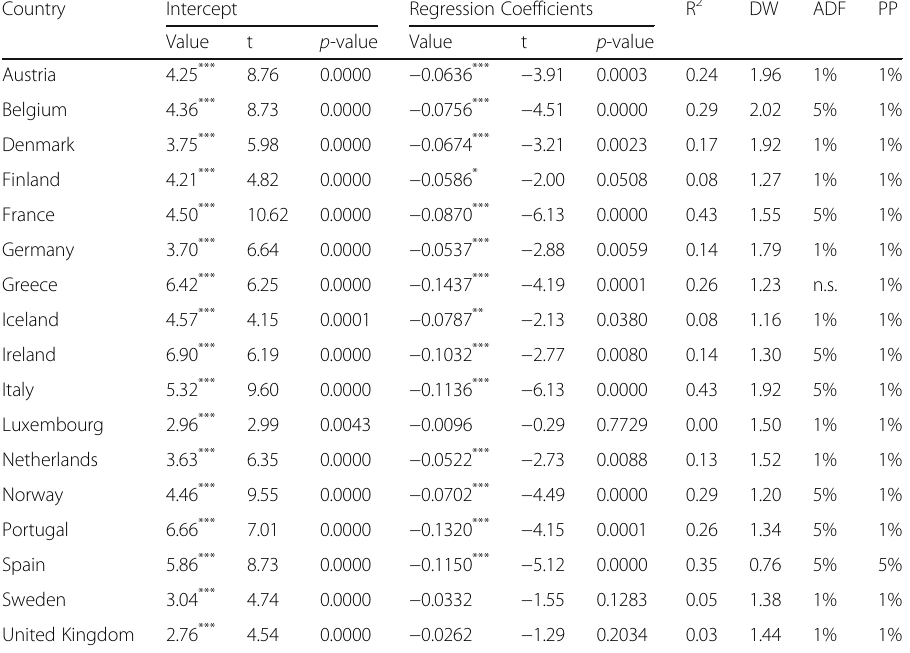
Table 1 Estimated Linear Trend Parameters for Real GDP per Capita Growth Rates in % 1961 – 2011 a Country Intercept Regression